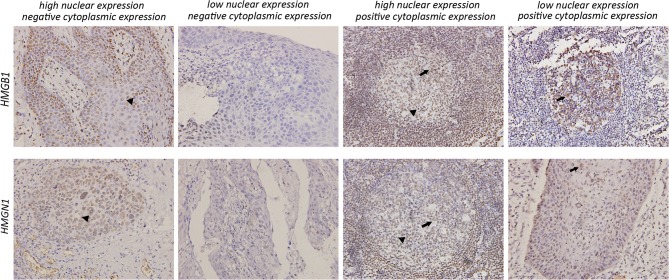
Various expression patterns of HMGB1 and HMGN1 in tumor cells (×200). In tumors characterized by positive cytoplasmic expression of HMGB1 and HMGN1, a large number of infiltrating lymphocytes could be observed around tumor cell nest. All images show both nuclear expression (filled arrowhead) and cytoplasmic expression (arrowhead) of tumor cells.